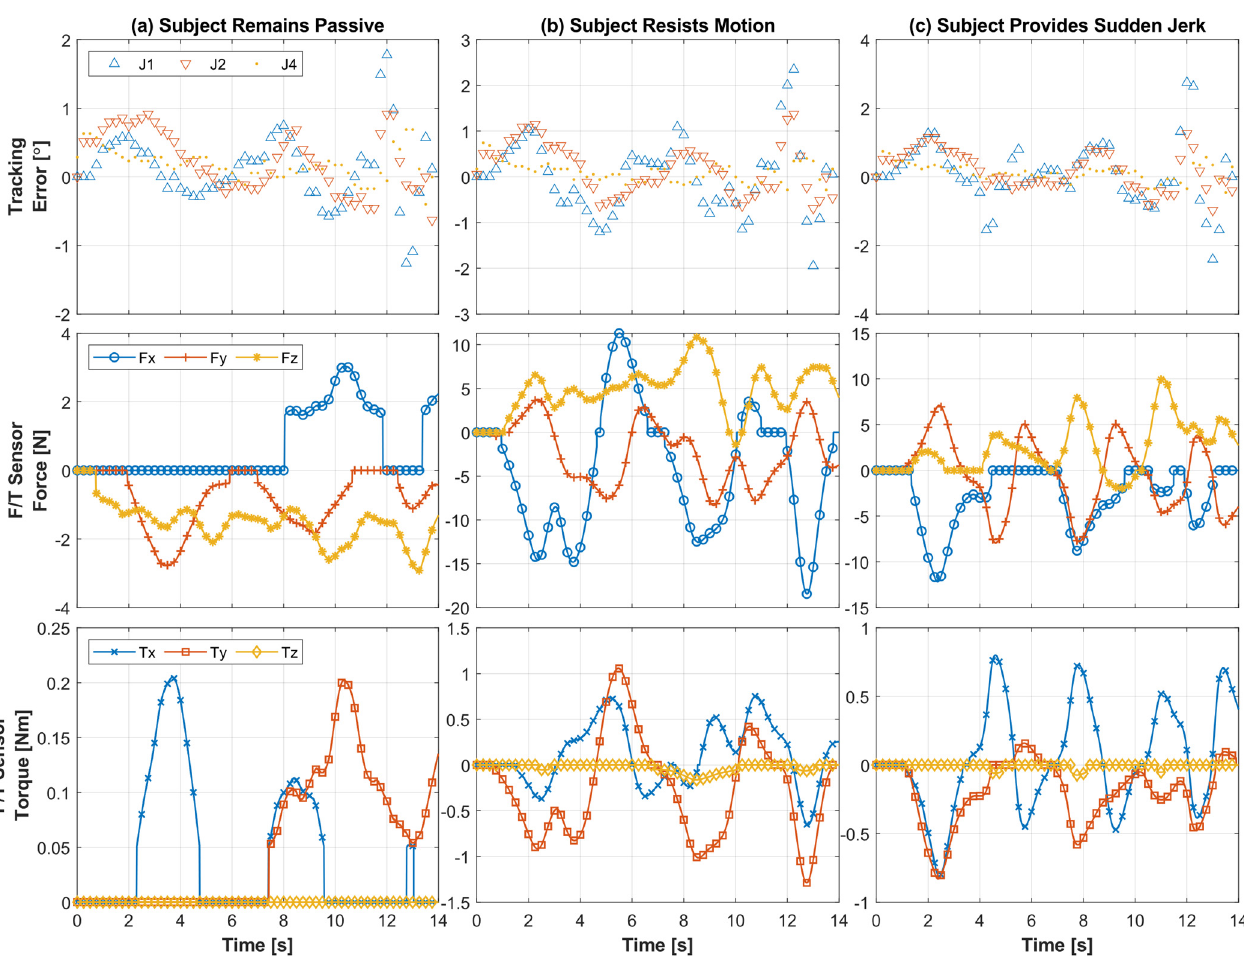
Figure 10. Tracking error and associated force/torque sensor data during diagonal reaching exercise of Subject B, while the subject ( a ) remains passive during the exercise motion, ( b ) resists the motion, and ( c ) provides sudden jerk force during the motion.